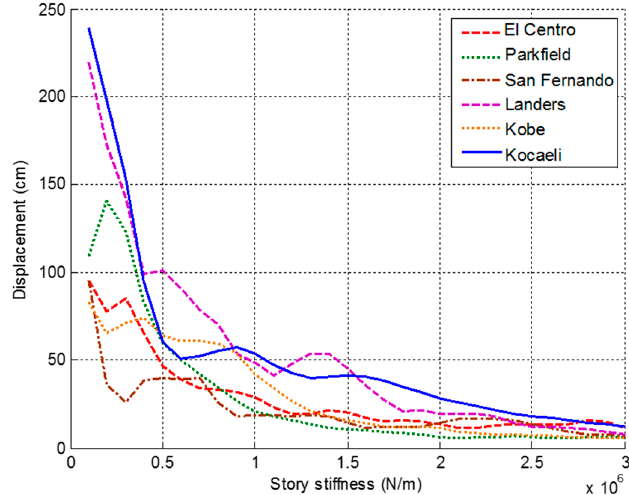
Figure 6. Peak displacement of the top story of building with respect to story stiffness.